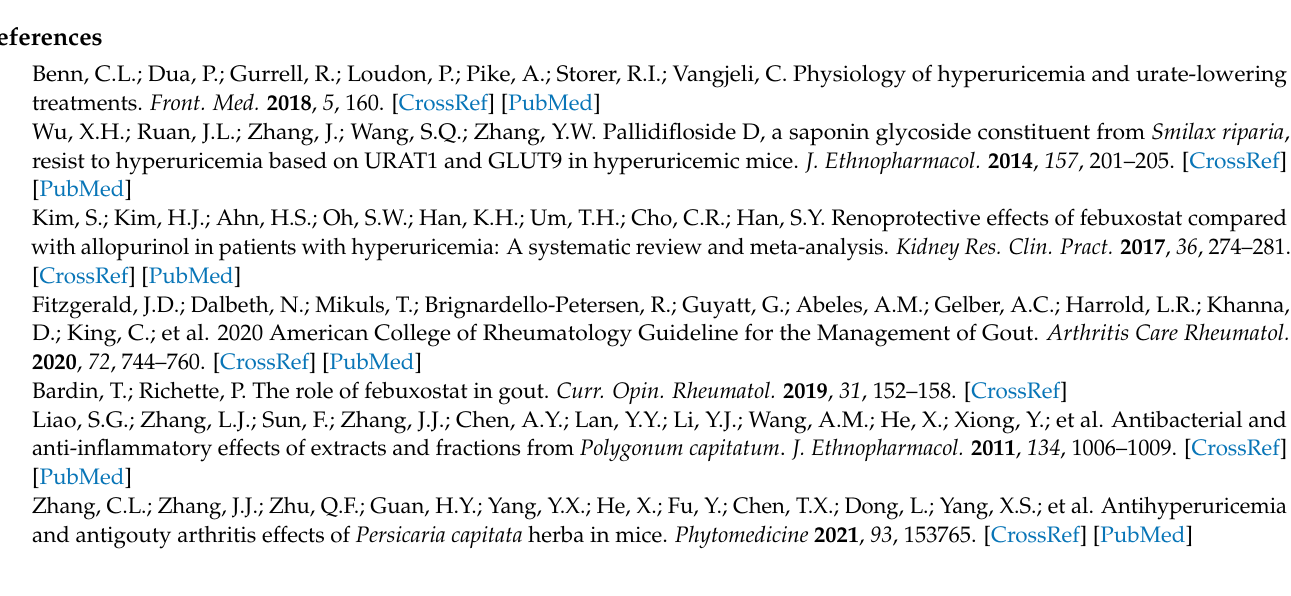
Figure S1: The chemical structures of the constituents from P. capitatum analyzed by UHPLC-Q- Orbitrap